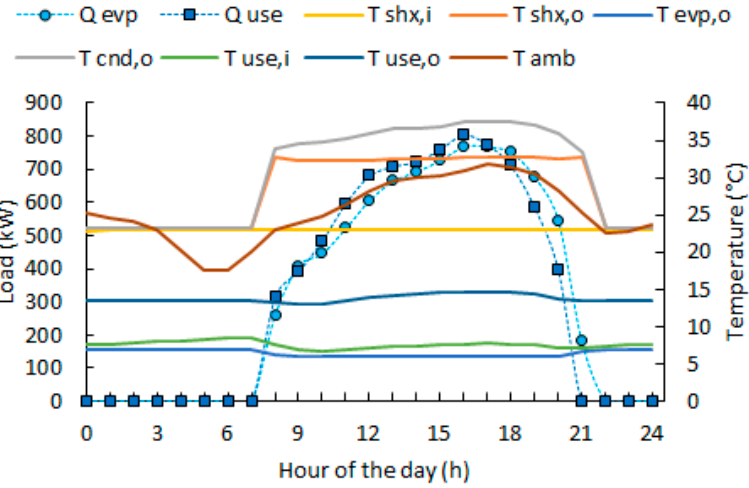
Figure 17. Transient operation in cooling mode (clean SHX).